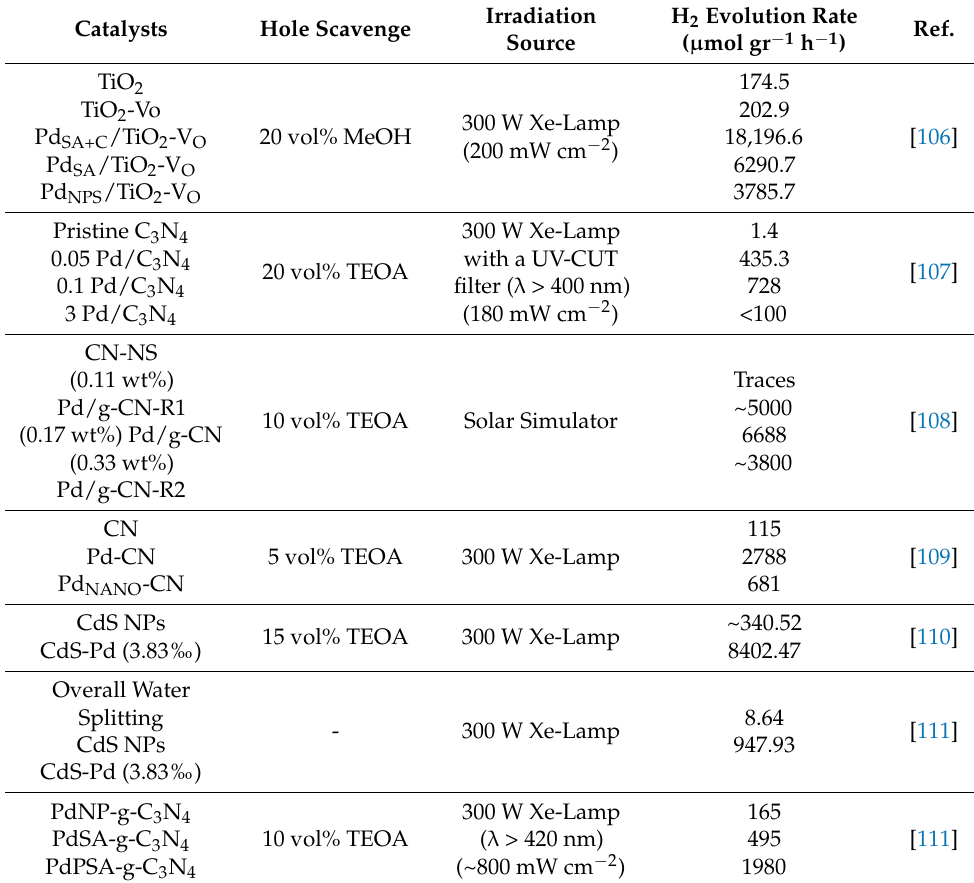
Table 2. Summary of Pd-based single atom photocatalytic systems used for H 2 production from H 2 O and their respective hydrogen evolution